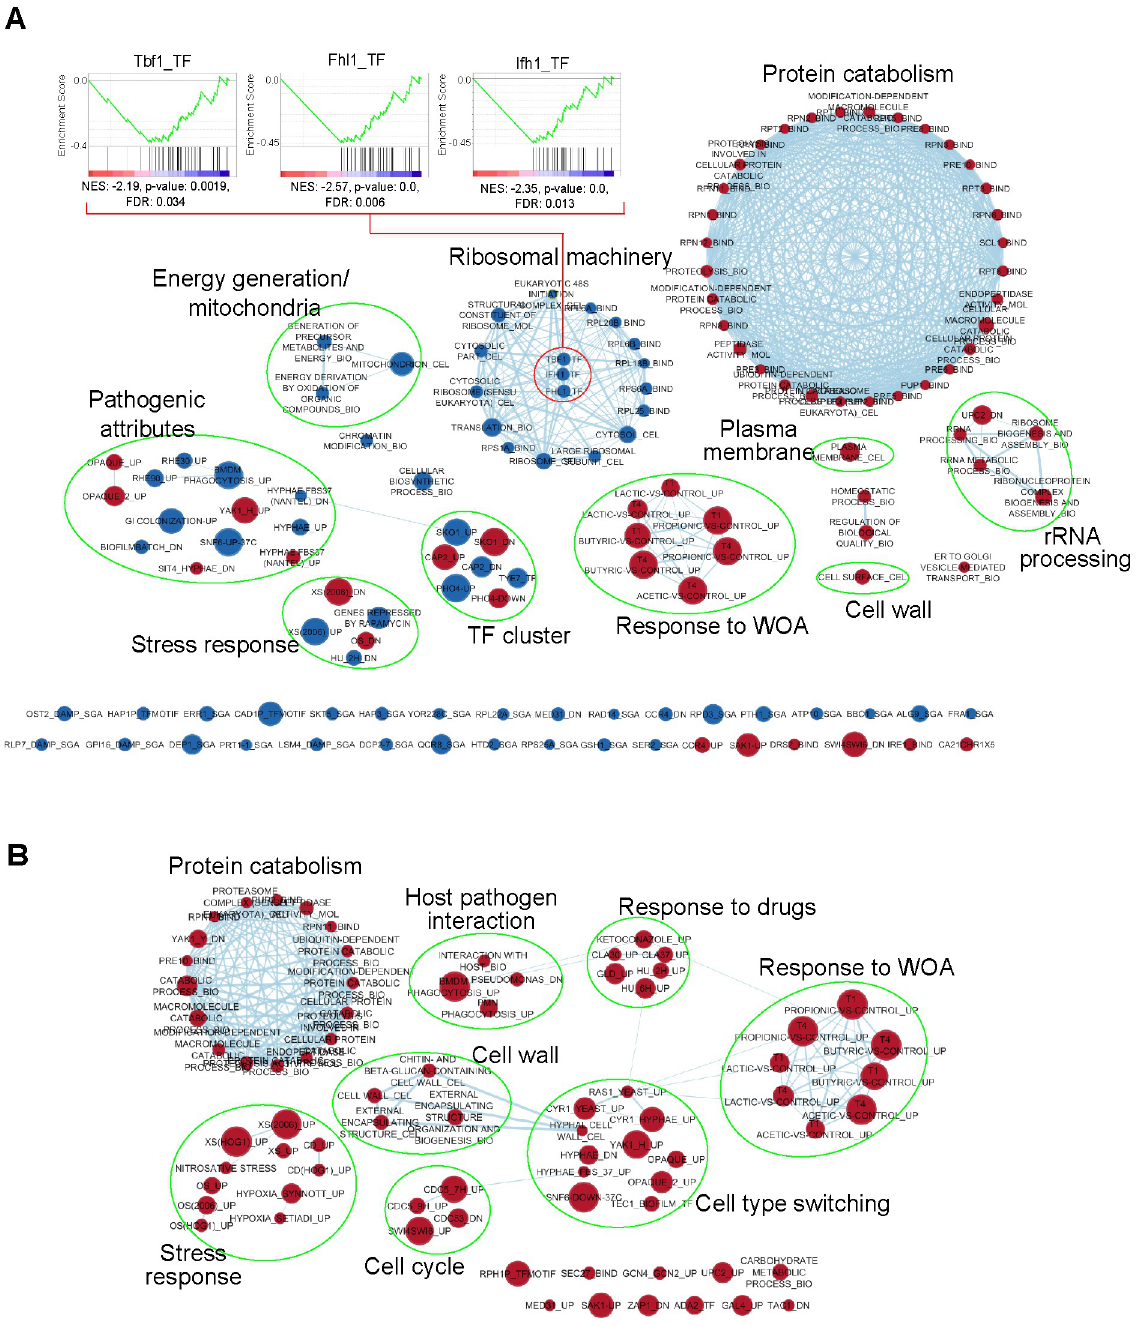
Fig 3. Enrichment analysis of the transcriptome and proteome of cells compromised in CaSth1 function. GSEA results of sth1/pTet-STH1 transcriptome ( A ) and proteome ( B ) profiles were visualized using Enrichment Map function of Cytoscape. In A , GSEA plots representing enrichment of targets of Tbf1, Fhl1 and Ifh1 transcription factors (red ellipse), are shown above the enrichment map. The targets were enriched among the downregulated candidates of sth1/pTet-STH1 , as indicated by a negative enrichment score on y-axis. The black lines on the x-axis represent individual genes which are ranked by expression values along a color scale, where blue represents downregulated and red denotes upregulated candidates (NES: Normalized Enrichment Score; FDR: False Discovery Rate). In the enrichment maps of A and B , the size of each solid circle (gene set) is proportional to the number of differentially expressed genes in that category and various such circles are connected by blue lines based on the number of overlapping genes. Gene sets corresponding to the down-regulated candidates are shown in blue circles while the red circles map to the up-regulated group. Clusters of gene sets that map to a common broader category are labelled and circled in green (WOA - Weak Organic Acids, TF - Transcription Factor).